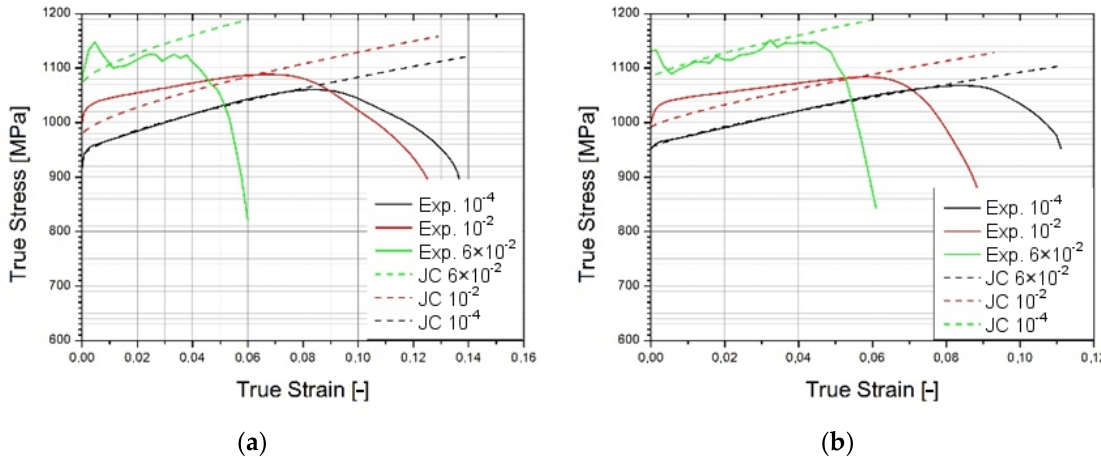
Figure 8. Stress–strain characteristics for 3 strain rates compared to Johnson–Cook results for specimen gauge length of 18 mm ( a ) and 30 mm ( b ).